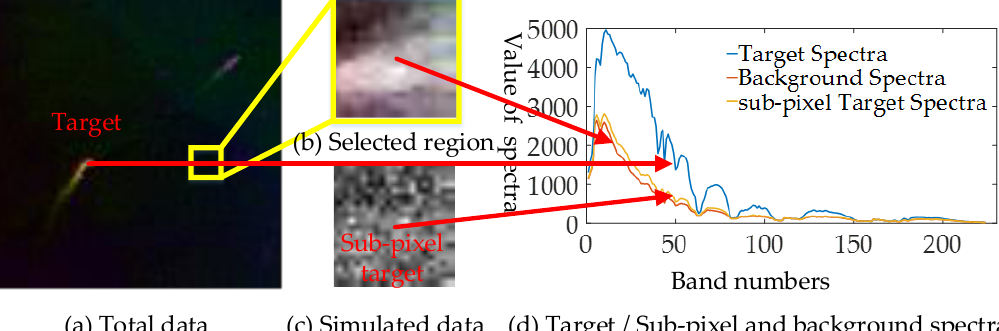
Figure 6. ( a , b ) False color image of the total dataset and the selected experimental region data, respectively; ( c ) first band image of the simulated data with the sub-pixel anomaly target; ( d ) target, with the background in location (10, 10) and mixed sub-pixel target spectra.